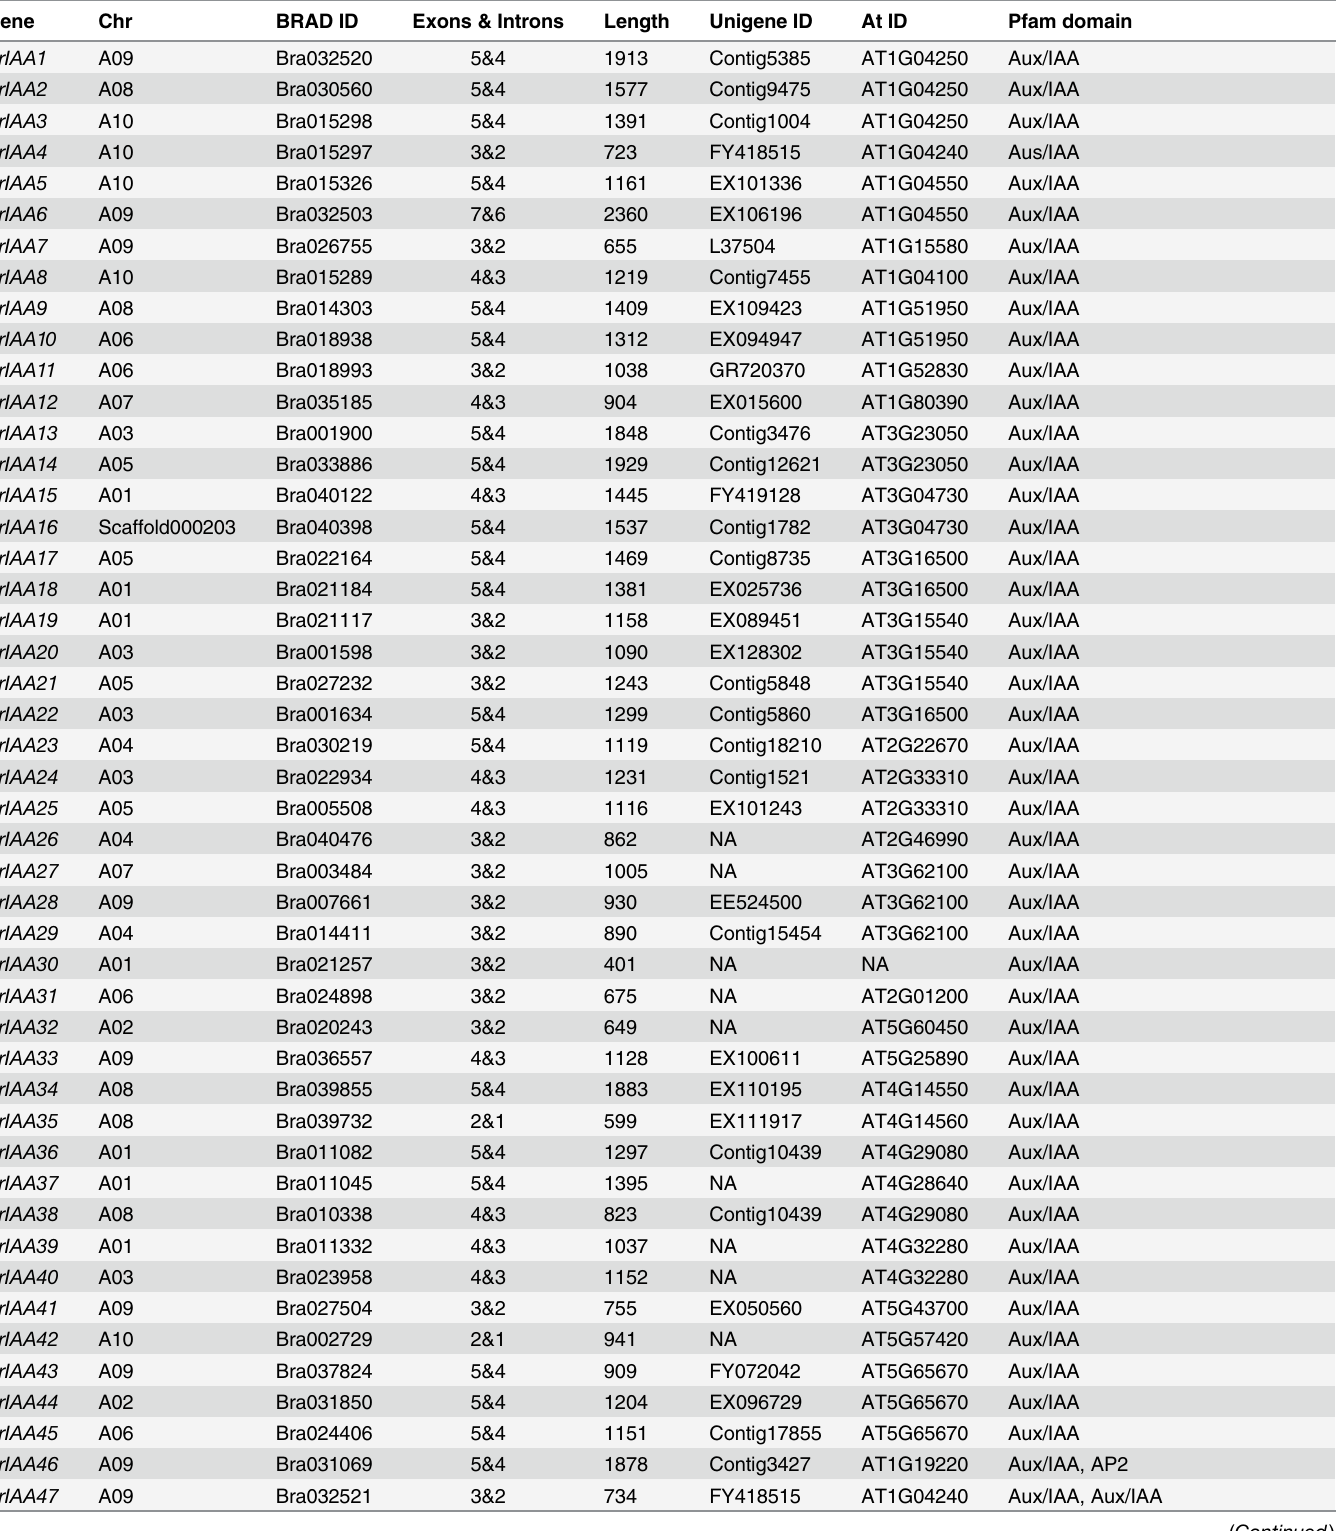
Table 1. The index of Aux/IAA genes in B . rapa